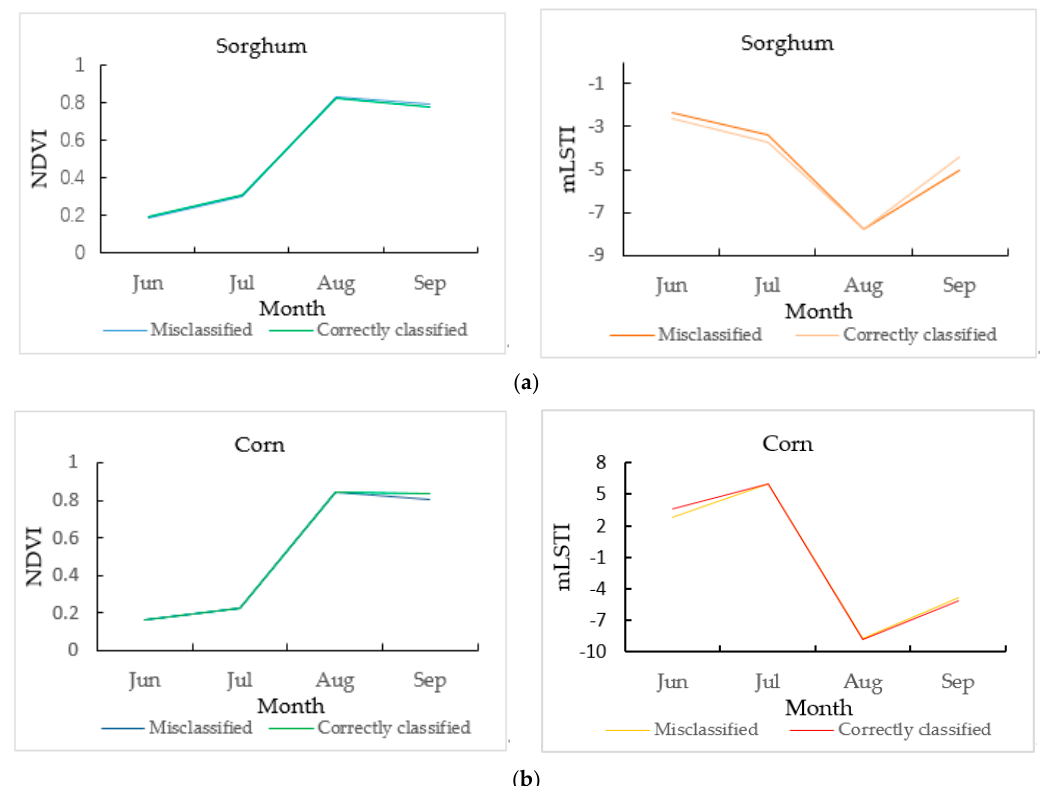
Figure 12. Mean NDVI and mLSTI curves of the selected area in area 2 for ( a ) sorghum, and ( b ) corn.